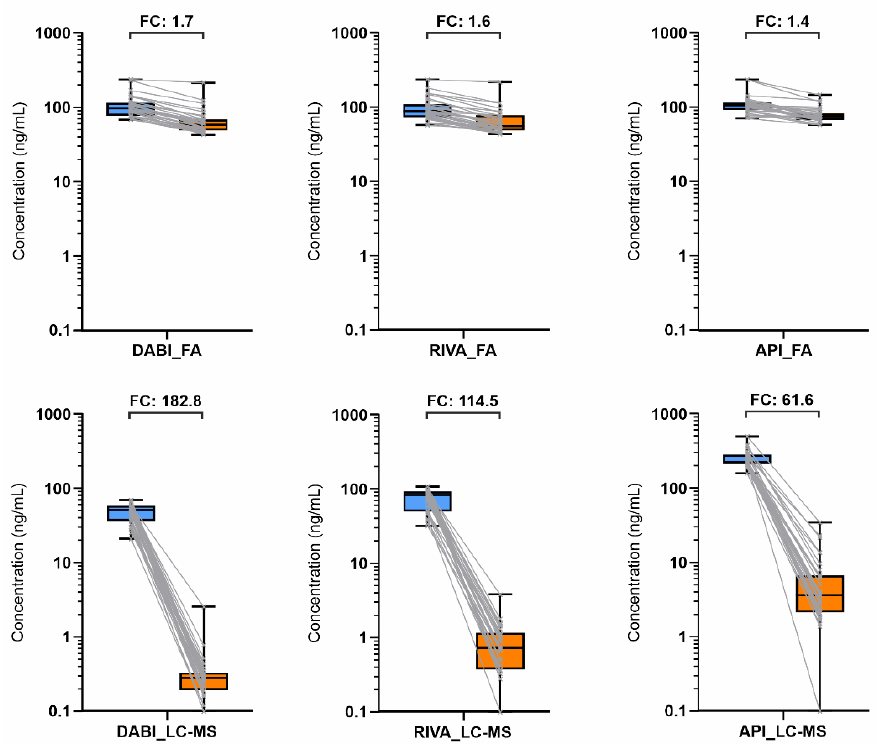
Figure 1. Distribution of DABI, RIVA, and API levels before (left blue) and after (right orange) DOAC procedure performed by dTT/anti-Xa (functional assays, FA) and LC-MS with the aforementioned fold changes (FC). Abbreviations: DABI, dabigatran; RIVA, rivaroxaban; API, apixaban; FA, functional assay.